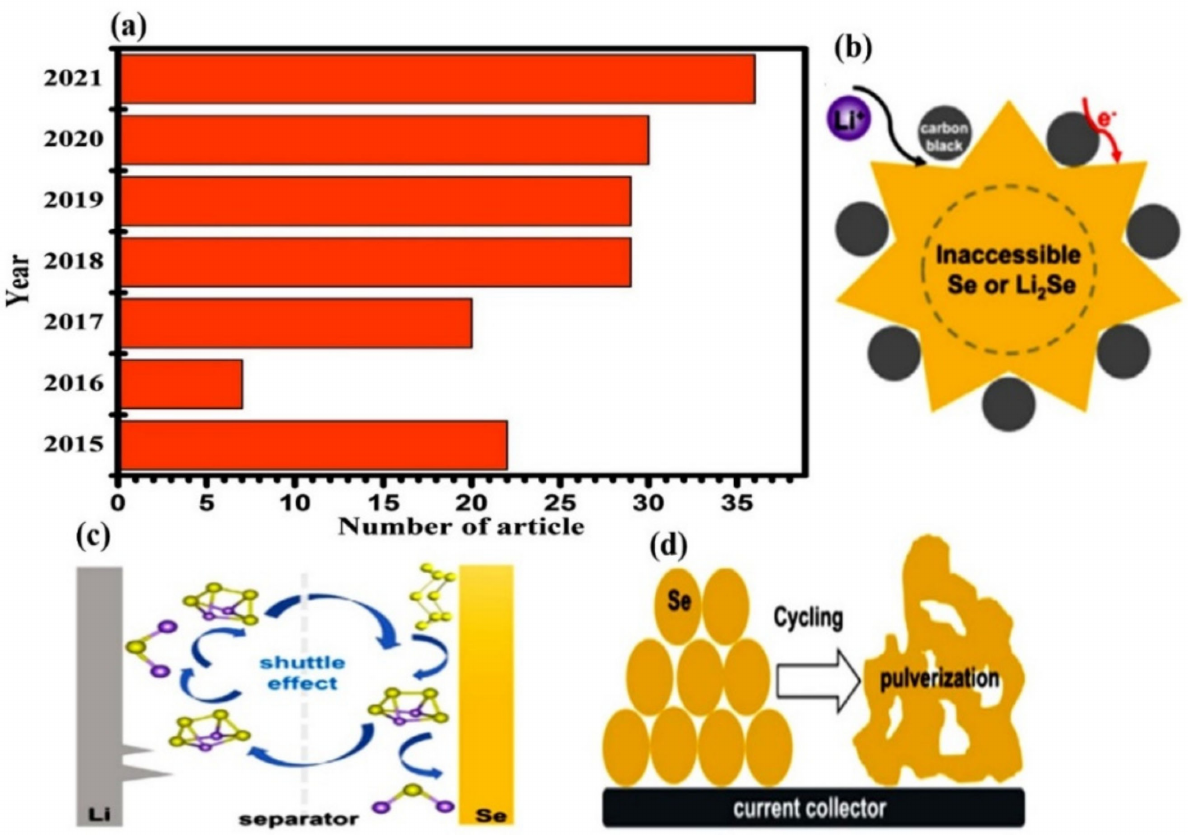
Figure 2. ( a ) According to the Web of Sciences database, articles on Li-Se batteries published in the last six years. The critical problems of Li-Se batteries: ( b ) the weak conductivity of solid Se or Li 2 Se with low utilization, ( c ) the shuttle effect of polyselenides, and ( d ) significant electrode pulverization during charge and discharge processes. Reproduced with permission from [28], Copyright 2021, Wiley Online